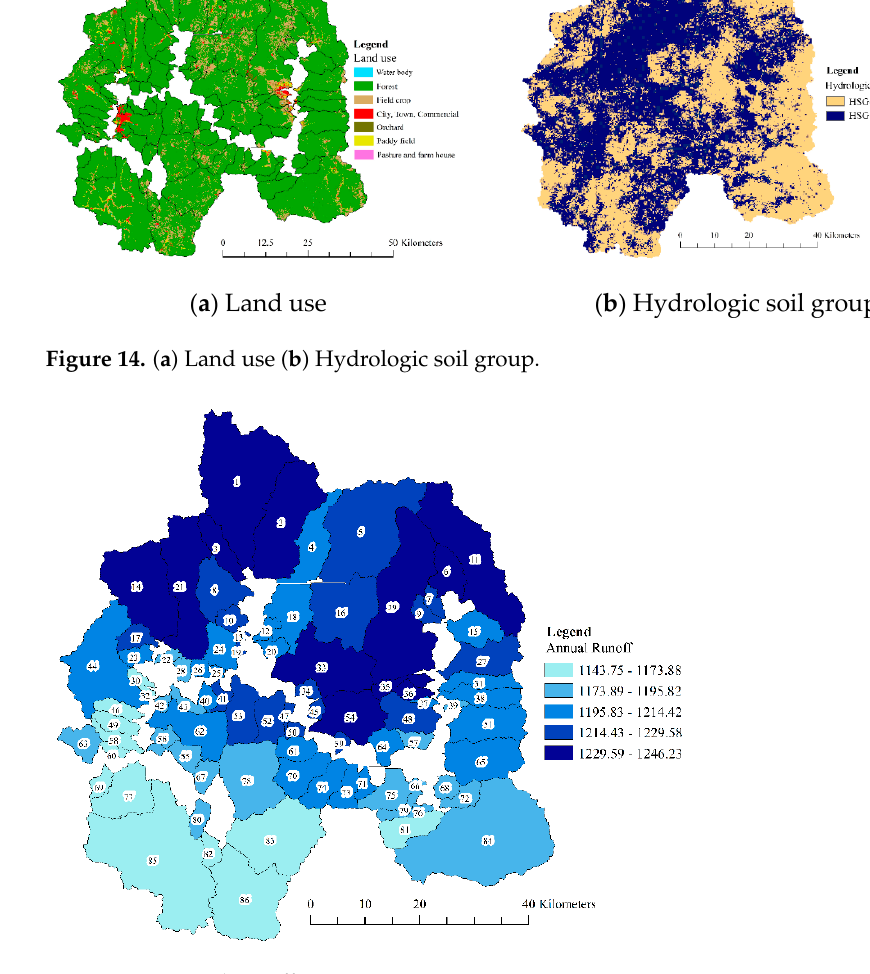
Figure 15. Annual runoff. Figure 15. Annual